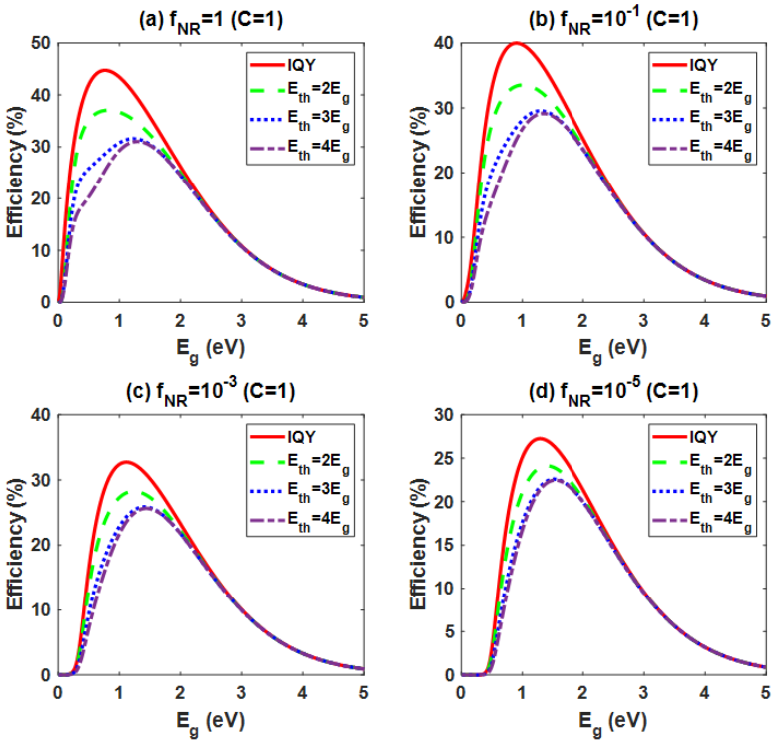
Figure 4. E g vs. theoretical efficiencies of the MEGSC with fixed f NR under one-sun illumination (C = 1). For this simulation, we used IQY and NQY (E th = 2∙E g , 3∙E g , 4∙E g ). f NR is 1, 10 − 1 , 10 − 3 , and 10 − 5 ).